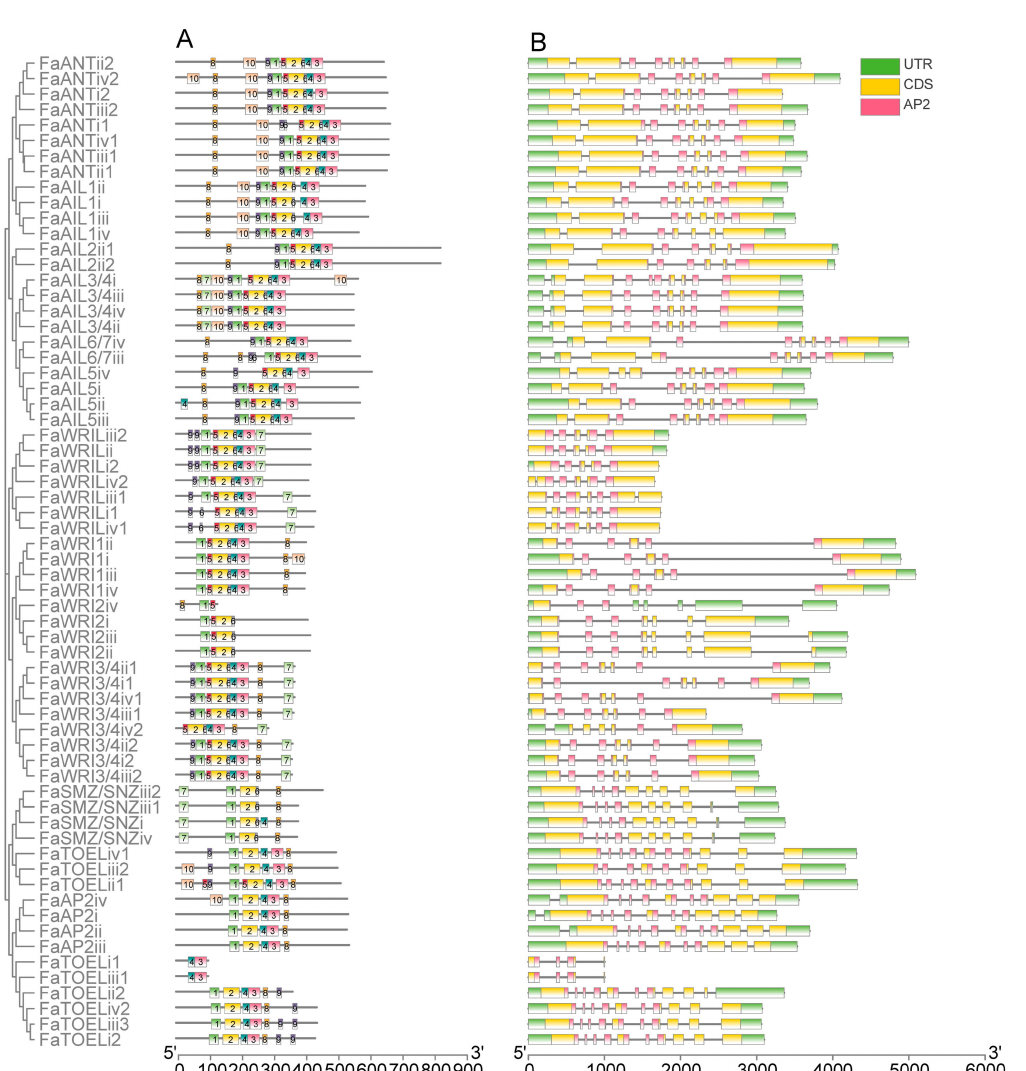
Figure 2. Motifs of AP2 proteins ( A ) and domain locations on the exon–intron structure of AP2 genes ( B ) of Fragaria × ananassa . ANT and euAP2 lineages are indicated with green and red strips, respectively. The euAP2, baselANT, and euANT groups are distinguished by blue, pink, and yellow labels, respectively. The numbers indicate 10 motifs, and the scale plate indicates the number of amino acid residues. The locations of the AP2 domains on exons (yellow) separated by introns (lines) are colored with red, and the scale plate indicates the number of